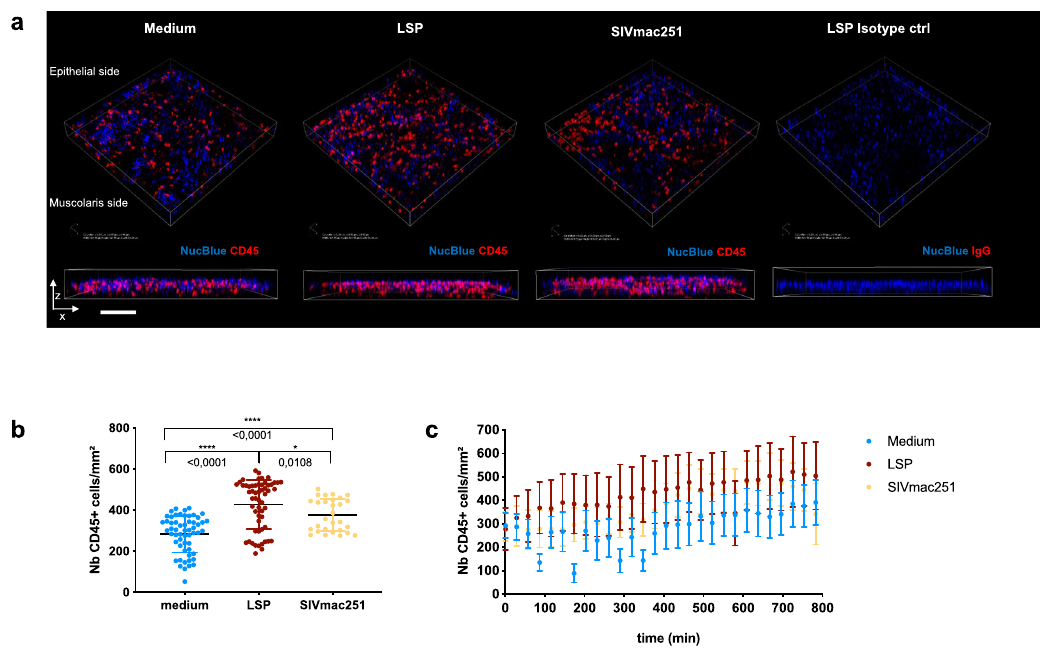
Fig. 6 Imaging of leukocyte recruitment by seminal plasma by time-lapse microscopy. a Three-dimensional rendering of representative fi elds obtained using NIS-Elements AR Analysis 5.02.0 (NIKON) and ImageJ software. Mouse anti-human CD45 antibody shows the leukocytes (red) and NucBlue dye label the nuclei (blue). Explants were either exposed to medium (without LSP), SIVmac251, or 25% LSP. An explant incubated with an isotype control antibody and exposed to LSP is shown as a negative control. A representative image obtained after 600 min of acquisition is shown. Scale bar = 25 µ m. Experiments were repeated three times. b Number/mm 2 of CD45 + cells imaged during 14 h of acquisition in medium, LSP, and SIV-treated explants. Each dot represents the number of cells/mm 2 imaged in the z-stack. Mean and SEM of three experiments are shown. Statistical analysis was performed using Wilcoxon signed-rank tests. c Number/mm 2 of CD45 + cells imaged every 29 min in the presence (red symbols) or absence (blue symbols) of seminal plasma as well as SIVmac251 (yellow symbols). The mean and SEM of three experiments are